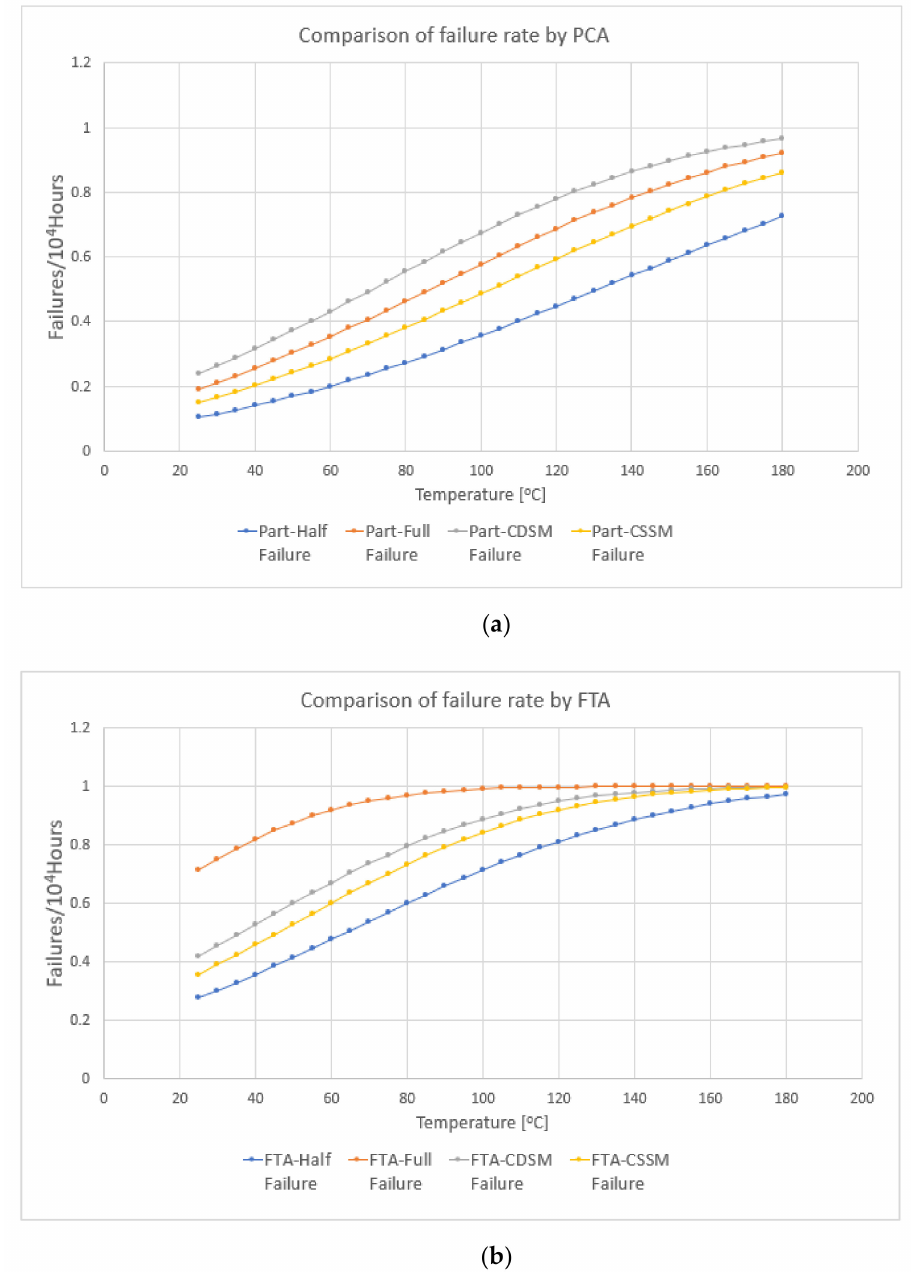
Figure 9. Comparison of failure rate ( a ) by PCA, and ( b ) by